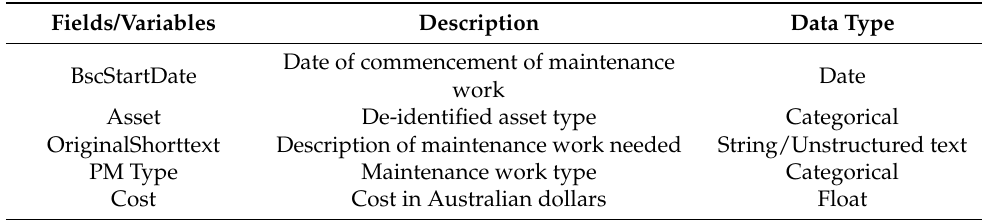
Table 2. Different fields in the dataset.